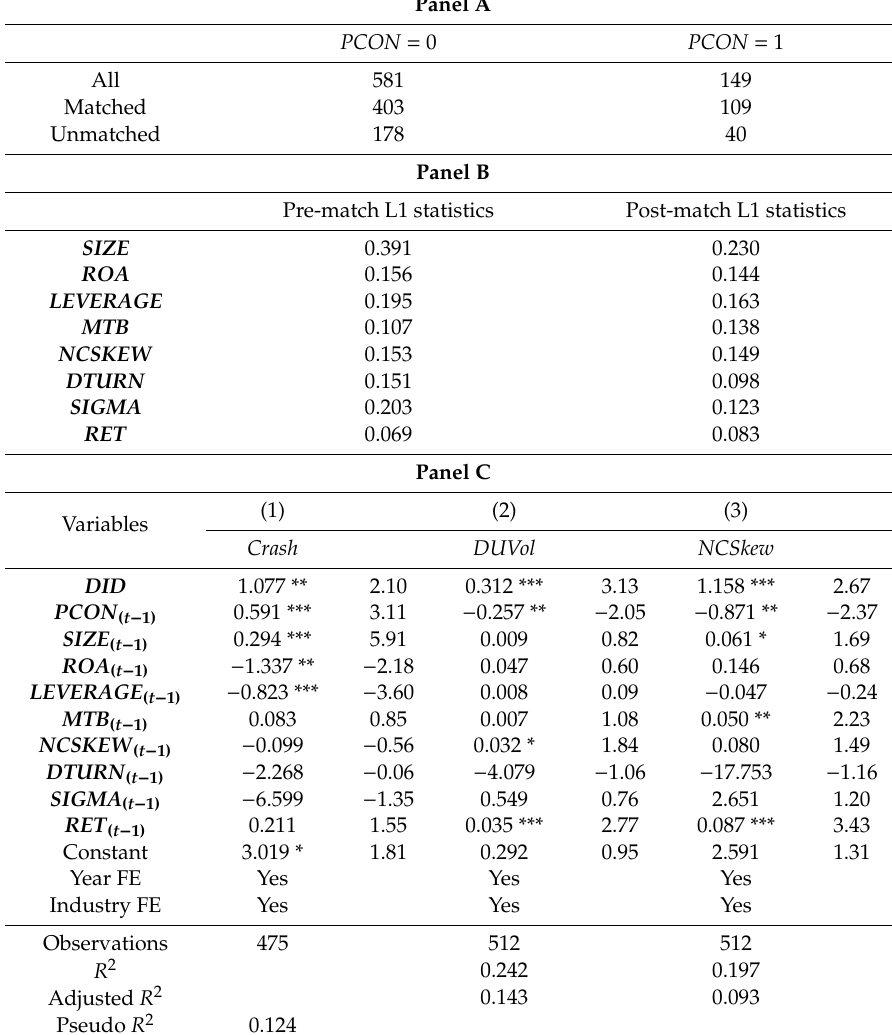
Table 10. Panel A. Coarsened exact matching method—matching summary. Number of strata: 171; Number of matched strata: 36. Panel B. Coarsened exact matching method—diagnosis of